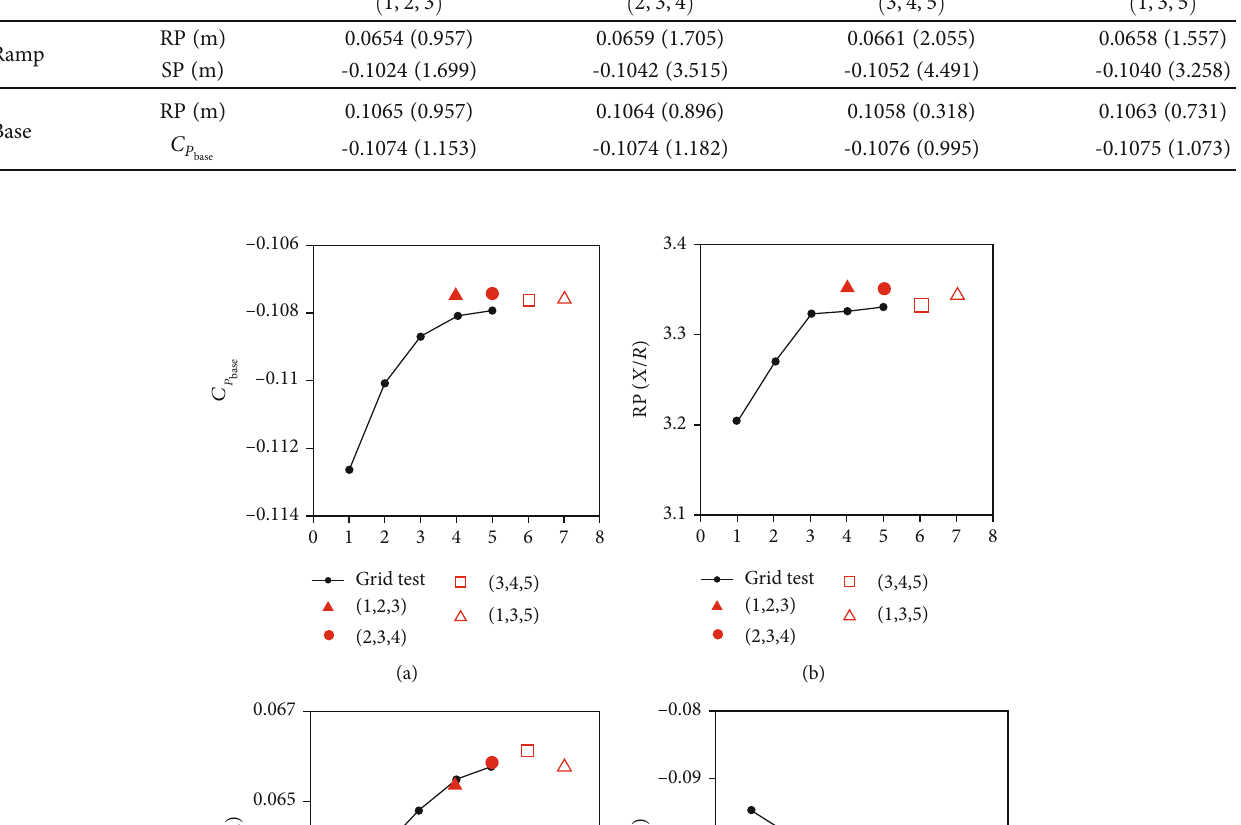
Table 7: Extrapolation values from GCI.